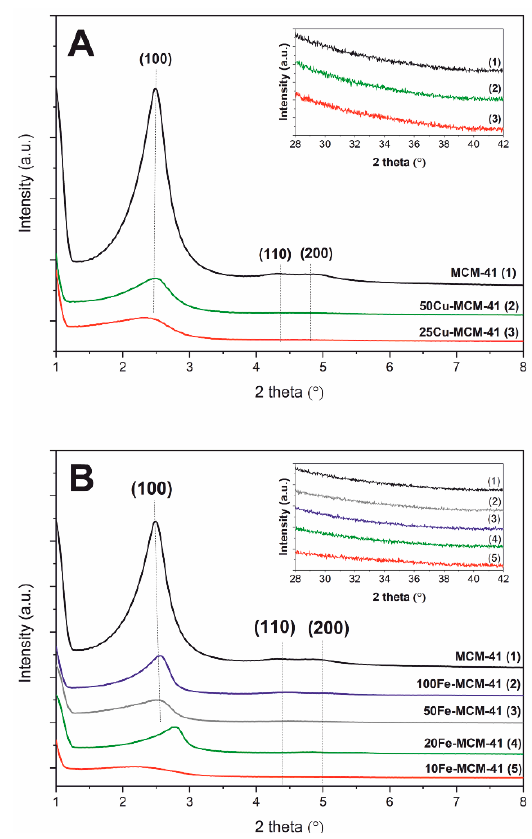
Figure 1. XRD patterns of the copper ( A ) and iron ( B ) containing spherical MCM-41 samples.